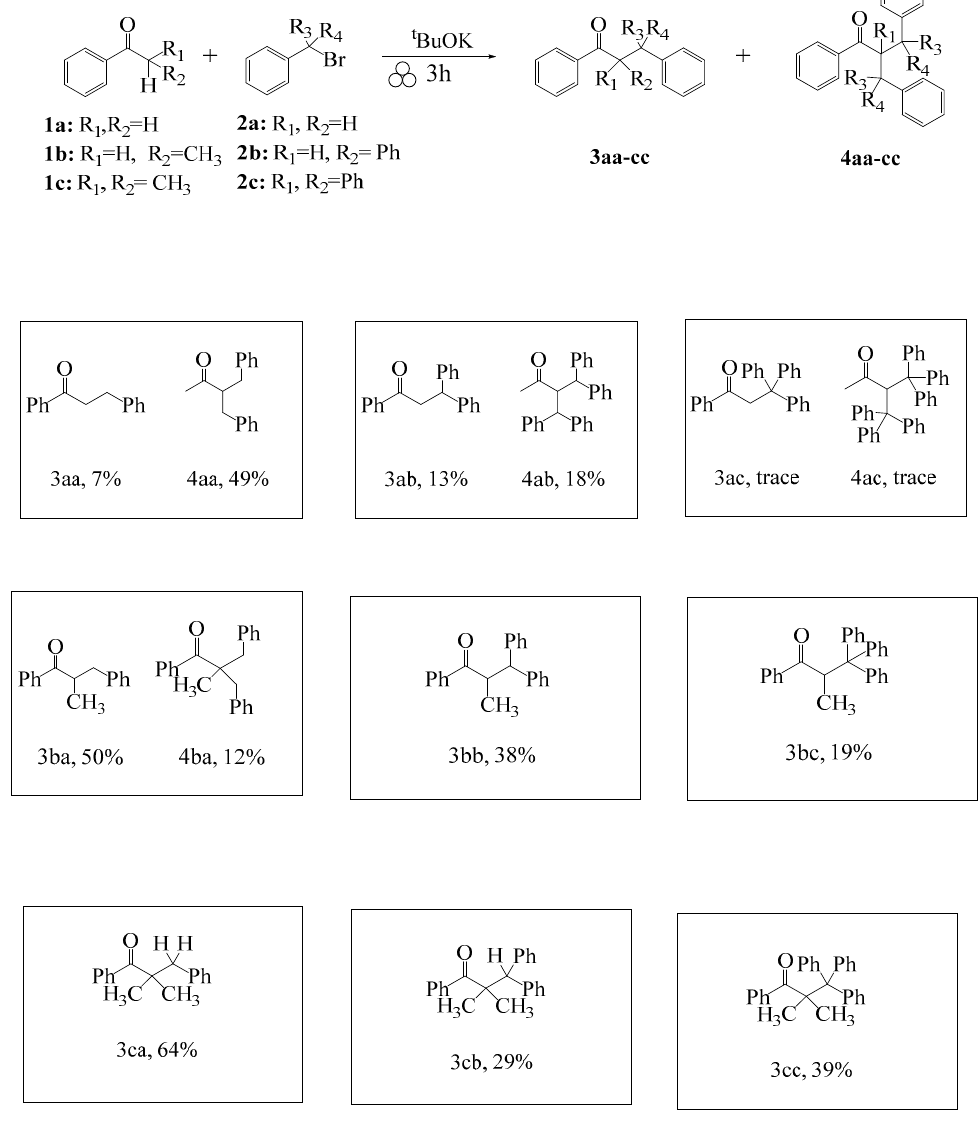
Figure 1. Enolate reactivity results.